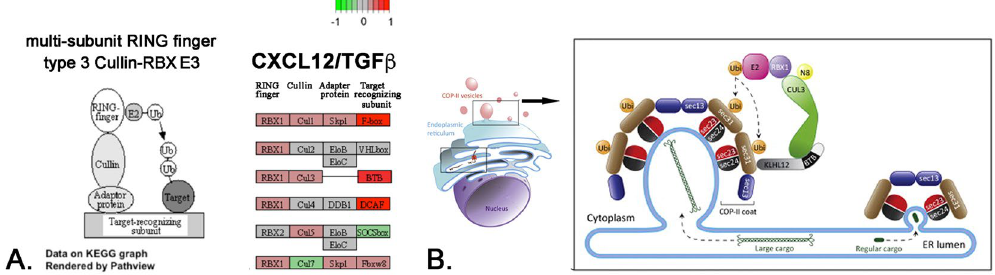
Figure 4. CXCL12 Transcriptionally Up-Regulates Cullin-RING Ubiquitin Ligases. ( A ) KEGG Pathway hsa04120 illustration (left) of multi-subunit RING-finger type 3 Cullin-RBX E3 ubiquitin ligase structure and of differential expression of specific genes in this complex (right). Genes significantly up-regulated consequent to CXCL12 treatment in red, up-regulated consequent to TGF β treatment in green, not differentially expressed in gray (arbitrary scale indicates extent of differential expression). ( B ) Illustration of COPII vesicle components which includes proteins encoded by several genes up-regulated consequent to CXCL12 but not TGF β treatment. Modified from 13 and used with permission from Elsevier Limited (VAT number GB 494 6272